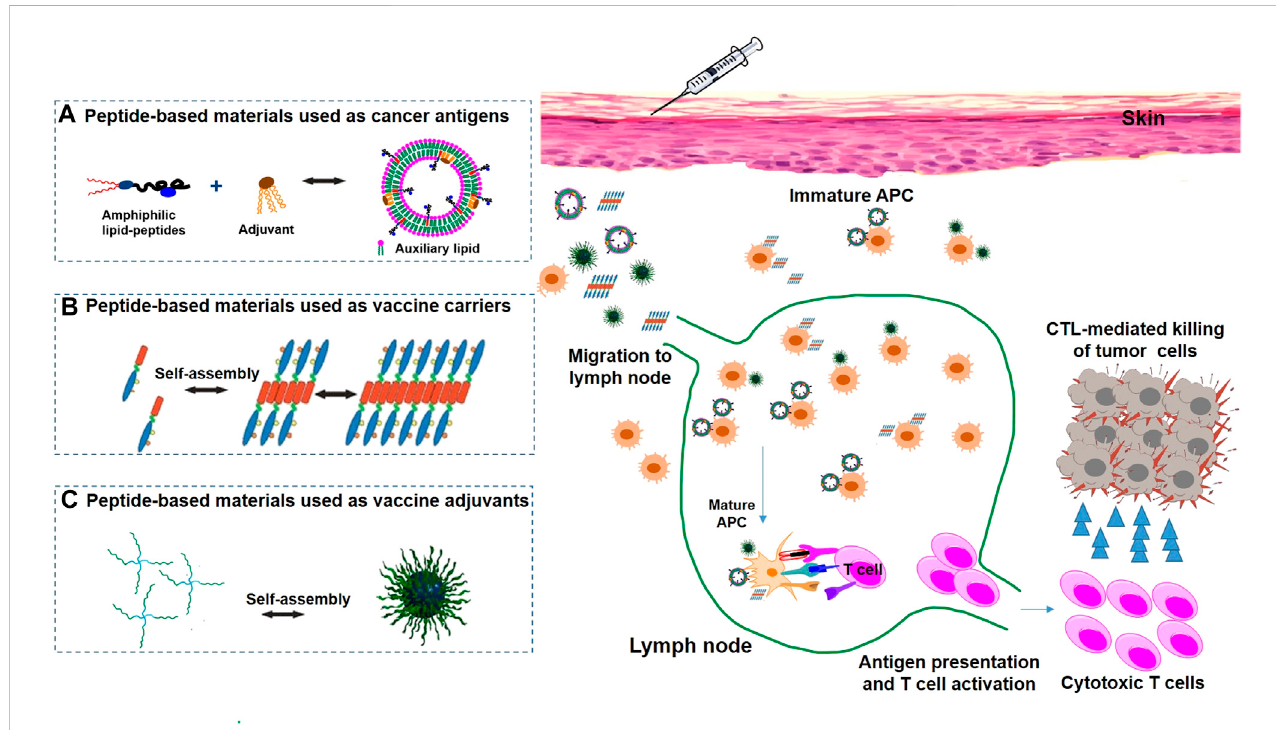
Peptide-based nanomaterials used in cancer immunotherapy via various delivery systems, including peptide-based nanomaterials as antigens (A) , carriers (B) and adjuvants (C)